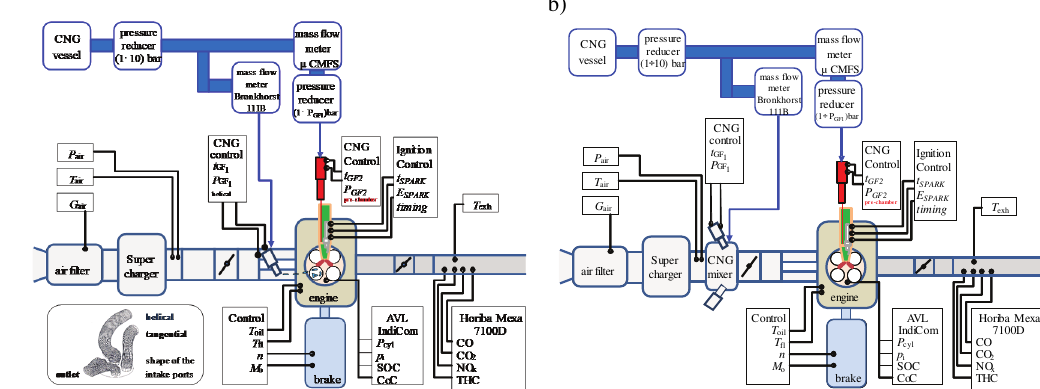
Fig. 4. Functional schematic of the test bench with AVL 5804 engine: a) prechamber injection and port fuel injection, b) prechamber injection and CNG mixer in the intake